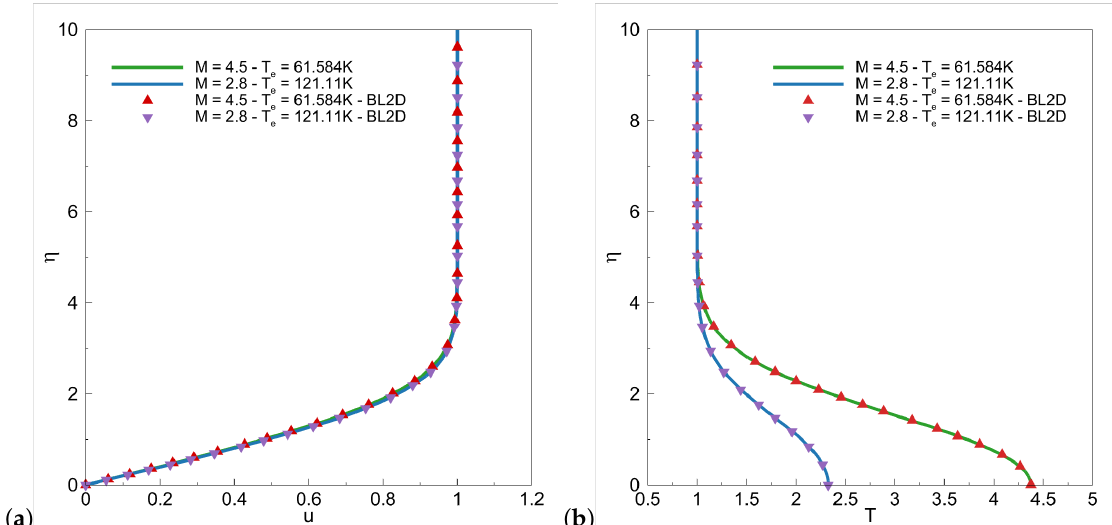
Figure 3. The distribution of the ( a ) velocity and ( b ) temperature of the compressible Blasius equation obtained by the given code and BL2D boundary-layer solver [20] for freestream Mach number 2.8 and 4.5 where freestream temperatures are 121.11 K and 61.584 K,